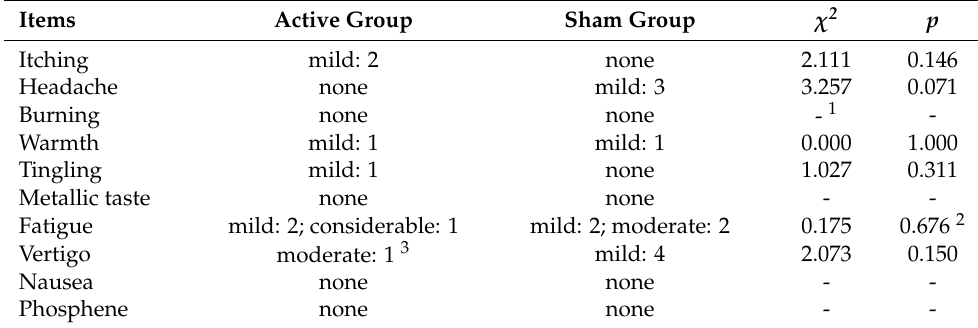
Table 2. Reported adverse effects (AEs) after TI-tACS and their statistical